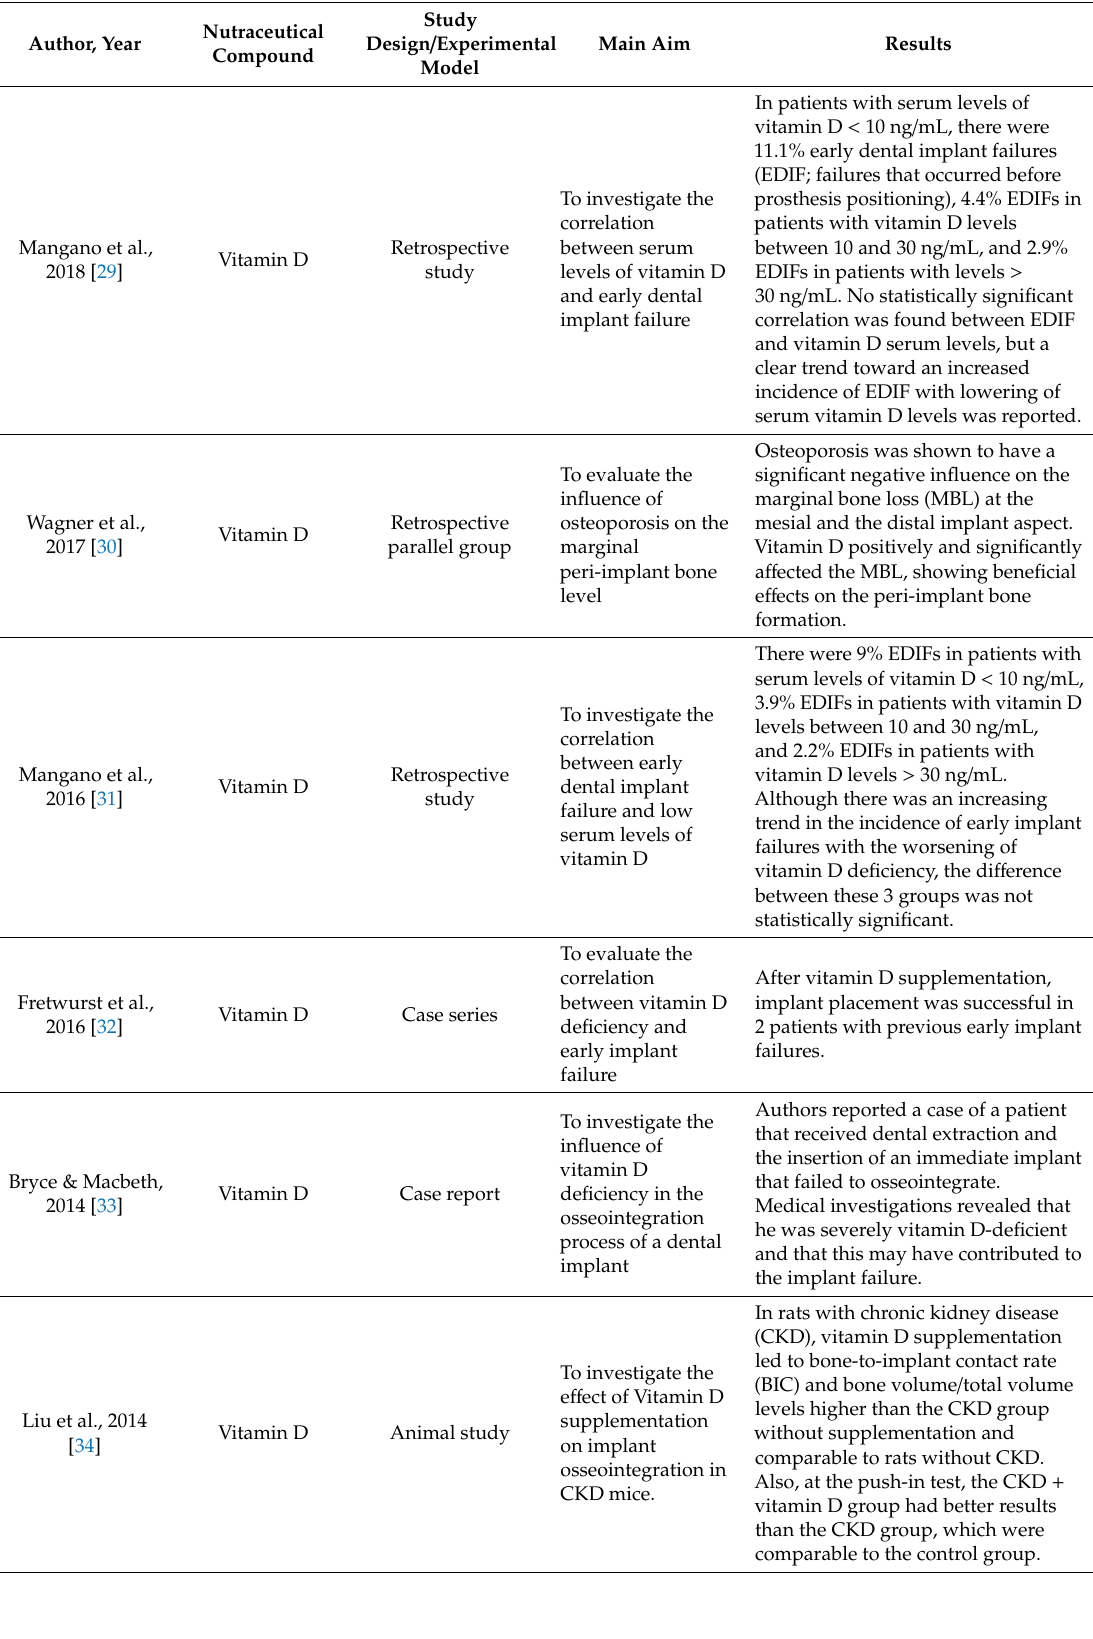
Table 2. Relevant data from each study included in the scoping